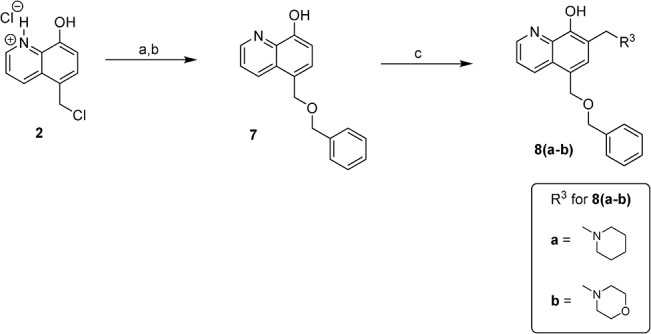
Synthesis of compounds 8a-8b.Reagents and conditions: (a) benzyl alcohol, 110 oC; (b) NH4OH, H2O, Et2O, pH 8–10; (c) paraformaldehyde, piperidine for 8a, morpholine for 8b,EtOH, reflux.